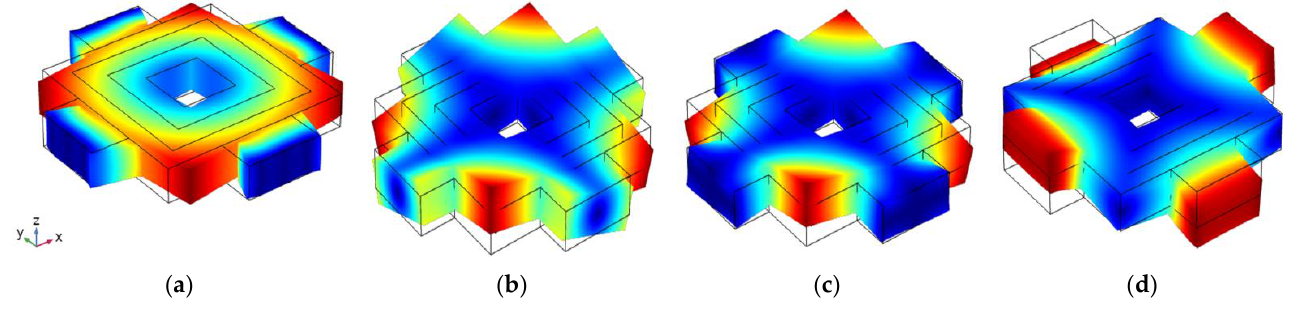
Figure 4. Vibration modes of the first and second bandgap edges: ( a ) Point A; ( b ) Point B; ( c ) Point C; ( d ) Point D.